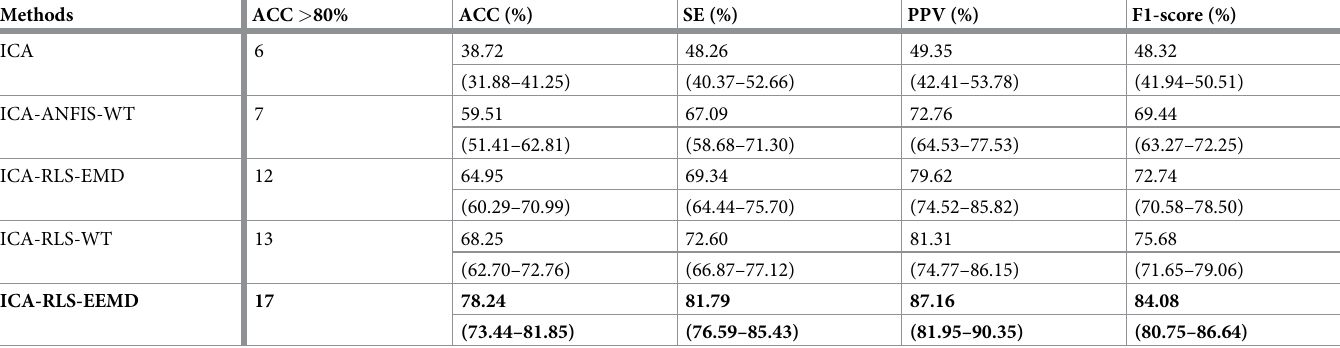
Table 9. Comparison of performance of the methods when extracting the fECG signals from the Challenge database. Second column provides the number of record- ings for which ACC > 80% was achieved. Columns three to six show average values calculated for 25 recordings from the database (the 95% confidence interval is reported in